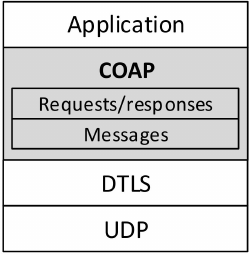
Figure 2. Datagram Transport Layer Security (DTLS)-secured Constrained Application Protocol (CoAP)